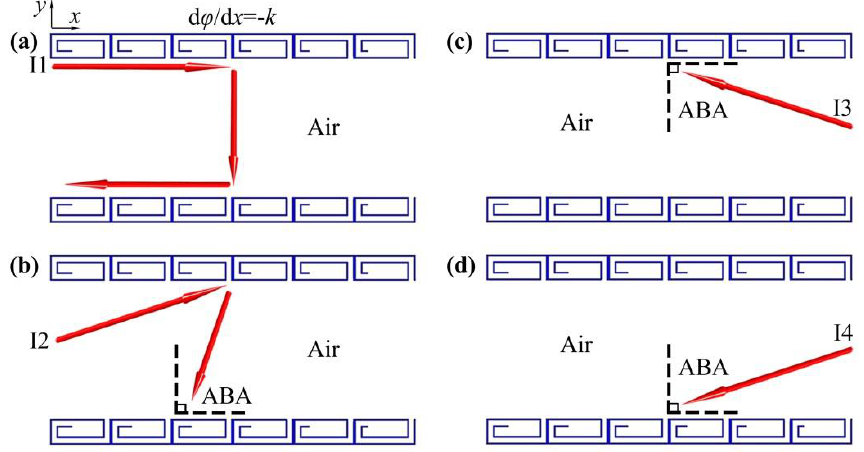
Figure 4. Schematic of acoustic propagation paths through the tunnel for the incident waves ( a ) I1, ( b ) I2, ( c ) I3 and ( d ) I4.